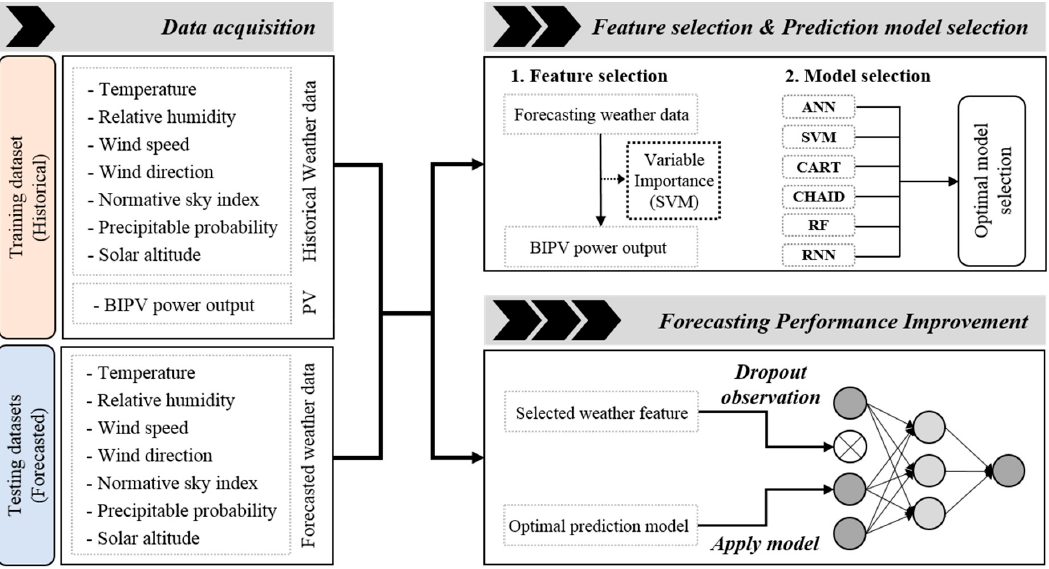
Figure 1. The overall framework for the short-term BIPV power output prediction.